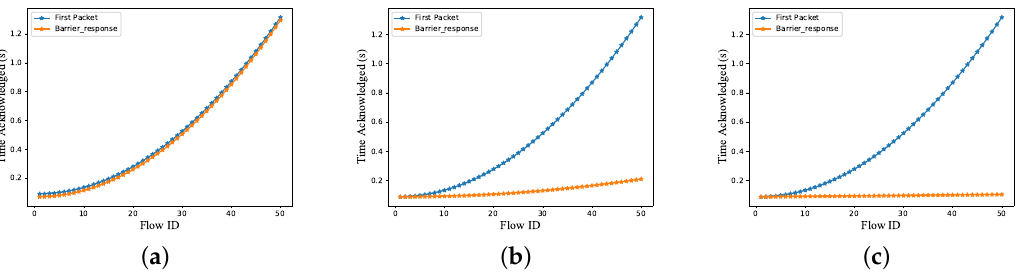
Figure 12. The correctness detection of Barrier on different SDN switches; ( a ) Pica8 P-3297, ( b ) Open VSwitch, ( c ) Switch 1.